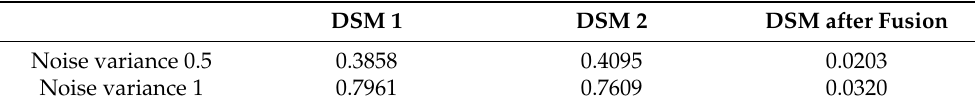
Table 3. Comparison of elevation errors before and after fusion of four-slope-roofed